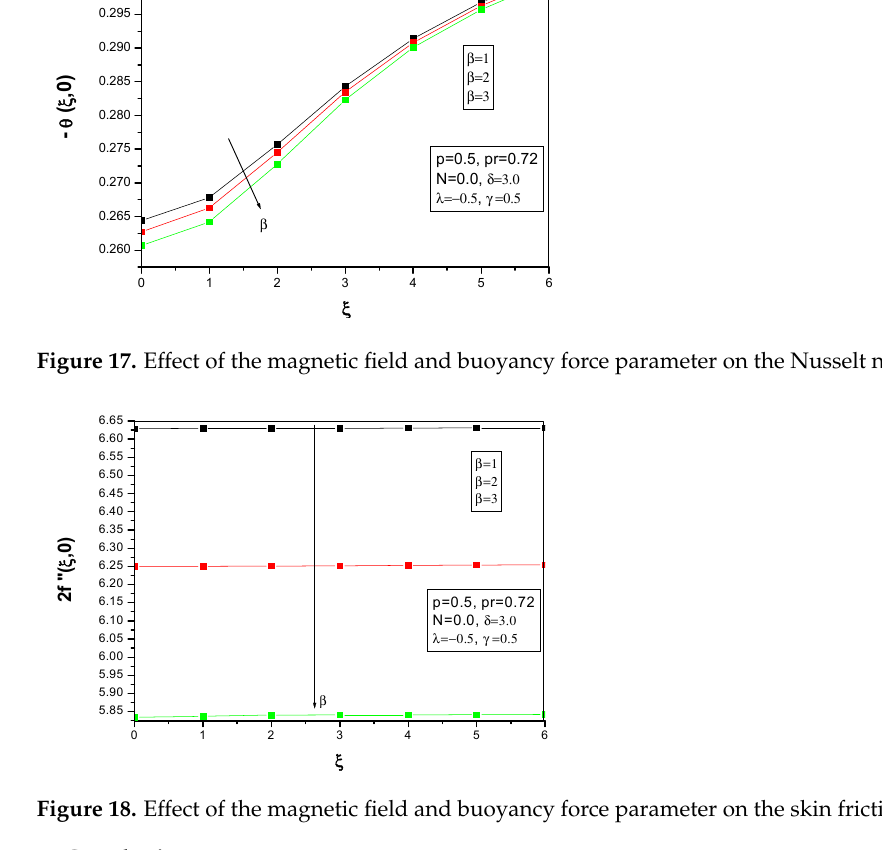
Figure 18. Effect of the magnetic field and buoyancy force parameter on the skin friction.